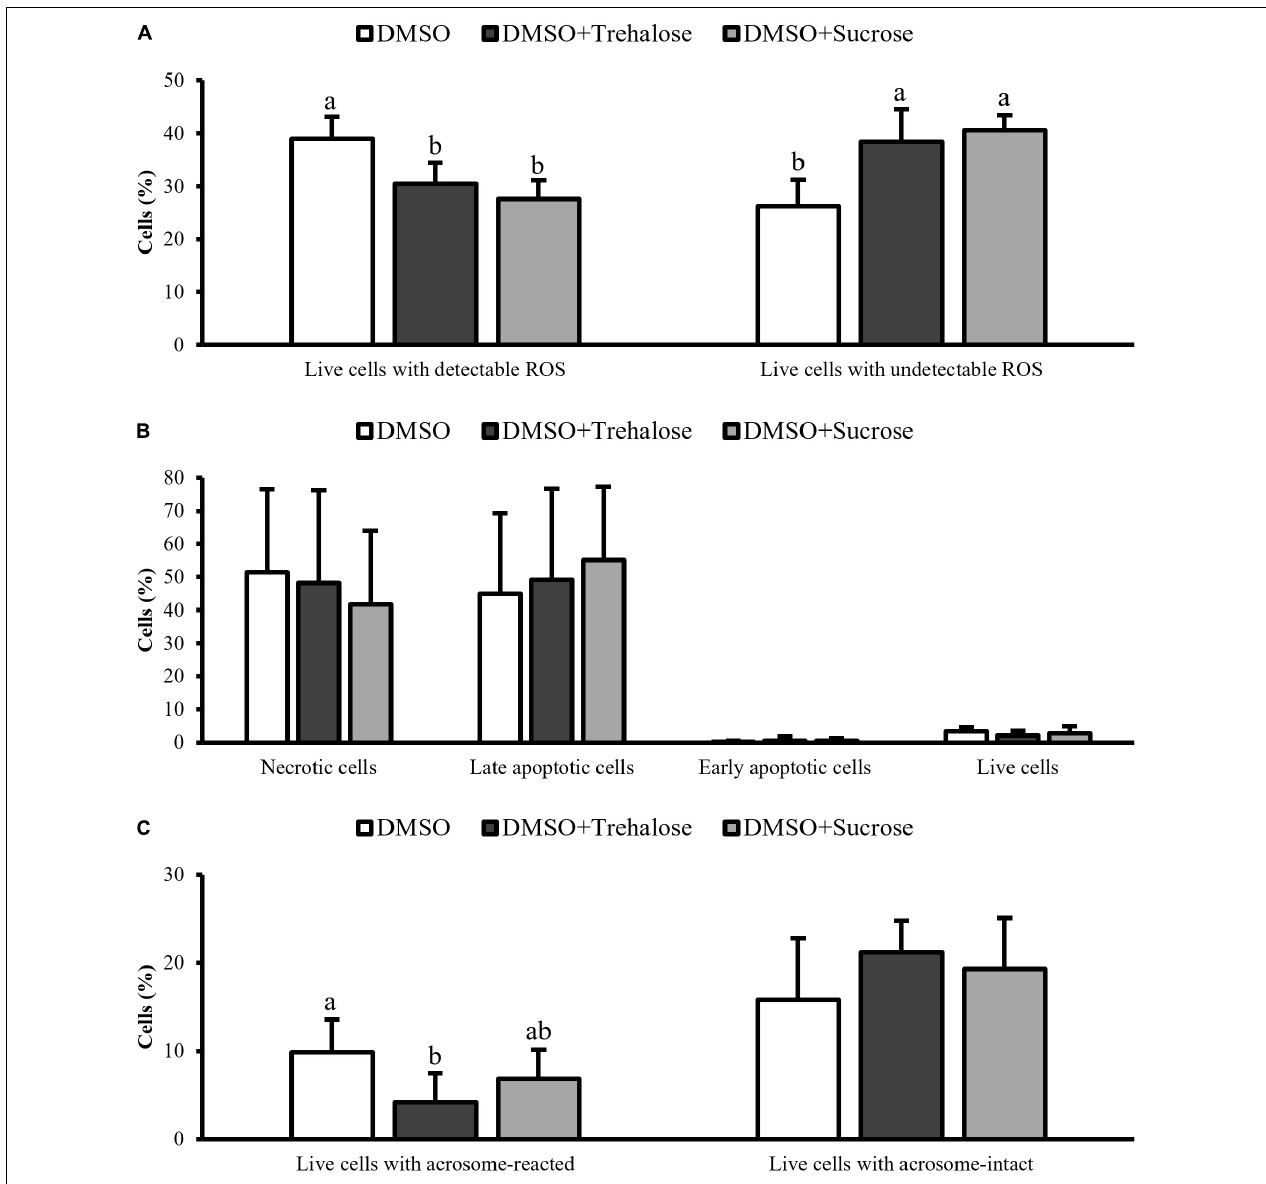
FIGURE 5 | Flow cytometry assays of C. angulata sperm frozen with 10% DMSO (white bar) or 10% DMSO supplemented with 0.45 M trehalose (black bar) or sucrose (gray bar). (A) ROS levels through double staining with DHE and SYTOX. (B) Programmed cell death by caspase-3/7 detection. (C) Acrosome integrity by FITC-PSA combined with PI. Results were expressed in mean percentages ± SD (ROS: n = 5; caspase and acrosome: n = 8 for DMSO and n = 9 for DMSO with trehalose or sucrose). Different letters show differences between cryoprotectant solutions for each sperm subpopulation (one-way ANOVA followed by SNK as post hoc test; p <